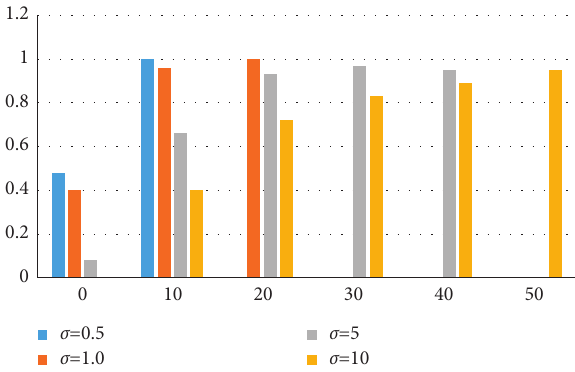
Figure 1: Geman–McClure function